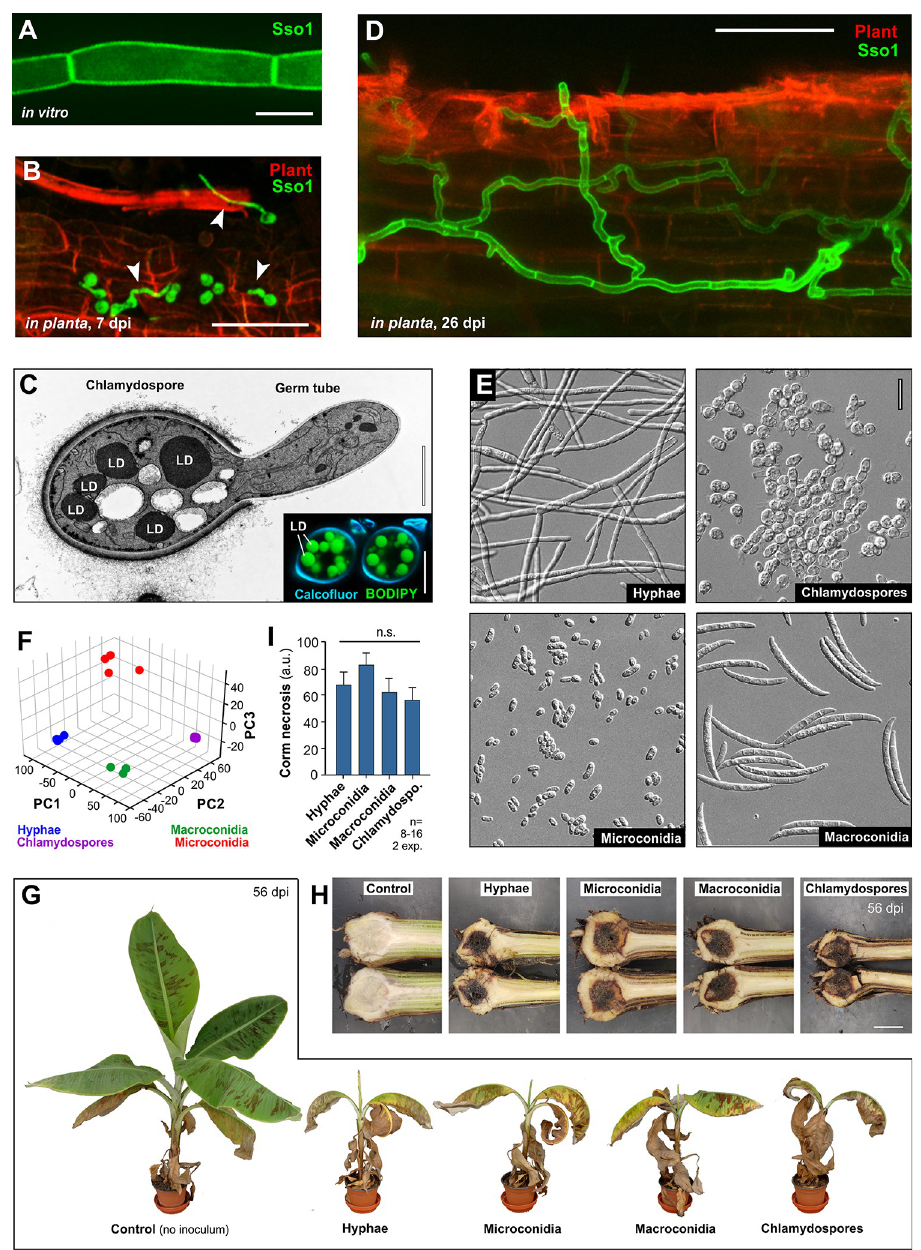
Fig 1. Pathogenicity and transcriptome of FocTR4 morphotypes. A Hyphal cells of FocTR4, expressing the plasma membrane marker Foc_GFP-Sso1 grown in liquid medium. Scale bar = 5 μ m. B Chlamydospores, expressing the plasma membrane marker Foc_GFP-Sso1 (green) on the surface of a root (red) at 7 dpi. Plant cell walls are visualised by their auto-fluorescence. Germ tubes are indicated by arrowheads. Scale bar = 50 μ m. C Lipid droplets (LD) in electron micrograph of a germinating chlamydospores and in a chlamydospores, stained with BODIPY 493/503 (green in inset; cell wall stained using calcofluor). Germination was triggered by incubation in PDB for 5 h. Scale bars = 2 μ m and 5 μ m (inset). D FocTR4 hyphae colonising banana root tissue at 26 dpi. Fungal cells express a fluorescent plasma membrane-located syntaxin (eGFP-Sso1, green), plant cell walls are visualised by their auto-fluorescence (red). Scale bar = 50 μ m. E Morphology of purified FocTR4 hyphae, microconidia, macroconidia and chlamydospores. Scale bar = 20 μ m. F Principal component analysis of RNA-preparations from 4 morphotypes of FocTR4. See also S1 Video. G Banana plants at 56 days after inoculation (dpi) with hyphae, microconidia, macroconidia or chlamydospores. All morphotypes cause leaf wilting, chlorosis and necrosis. H Necrosis of banana corms at 56 dpi with hyphae, microconidia, macroconidia or chlamydospores. Scale bar = 3 cm. I Quantitative assessment of necrosis in corm tissue after inoculation with the morphotypes. Bars in ( I ) represent mean ± SEM; sample sizes are indicated; statistical